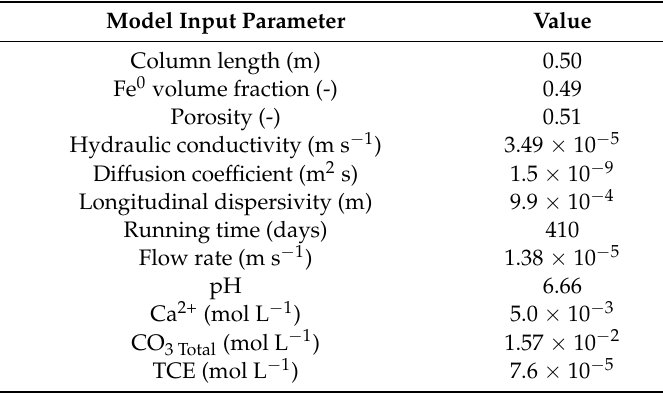
Table 1. Input parameters used in the simulation.